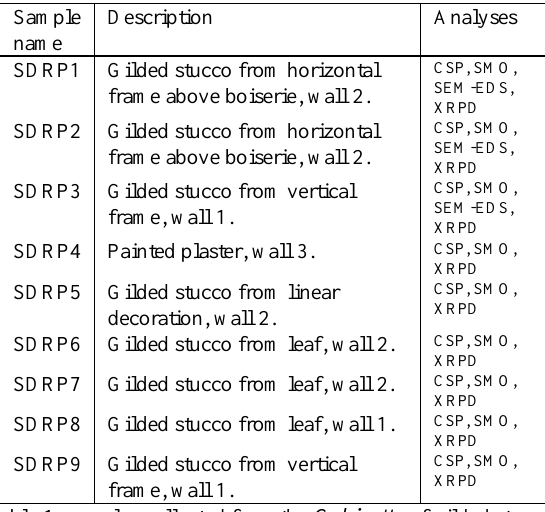
Table 1. samples collected from the Gabinetto of gilded stucco. CSP: cross section photomicrograph; SMO: stereo microscope observations; SEM-EDS: scanning electron microscope observation equipped with Energy Dispersive Spectrometry;